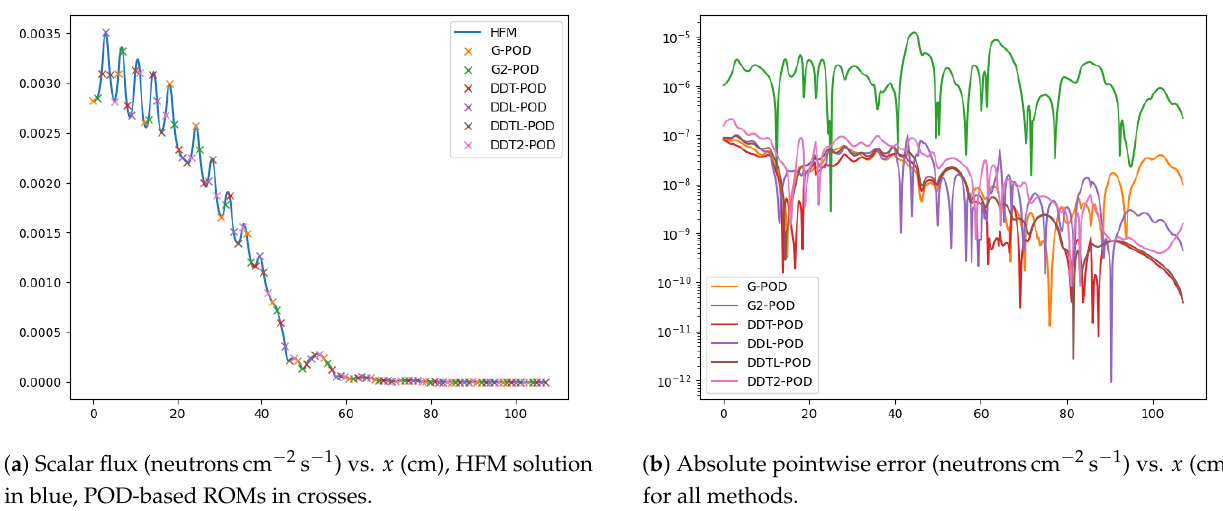
( b ) Absolute pointwise error (neutronscm − 2 s − 1 ) vs. x (cm) for all methods.